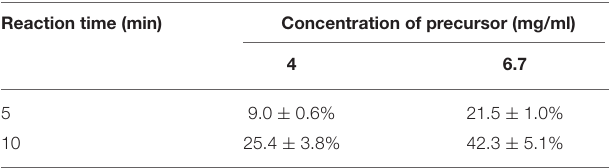
TABLE 2 | Result of the different reaction time on the [ 18 F]-fluorination yield of [ 18 F]DPA714 at 105 ◦ C reaction temperature (non-decay-corrected; n = 4). Reaction time